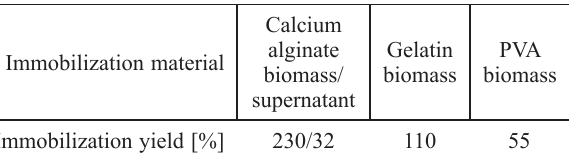
Table 1 – I mmobilization yield of Y. lipolytica KKP 379 bio- mass and supernatant from 40 h culture